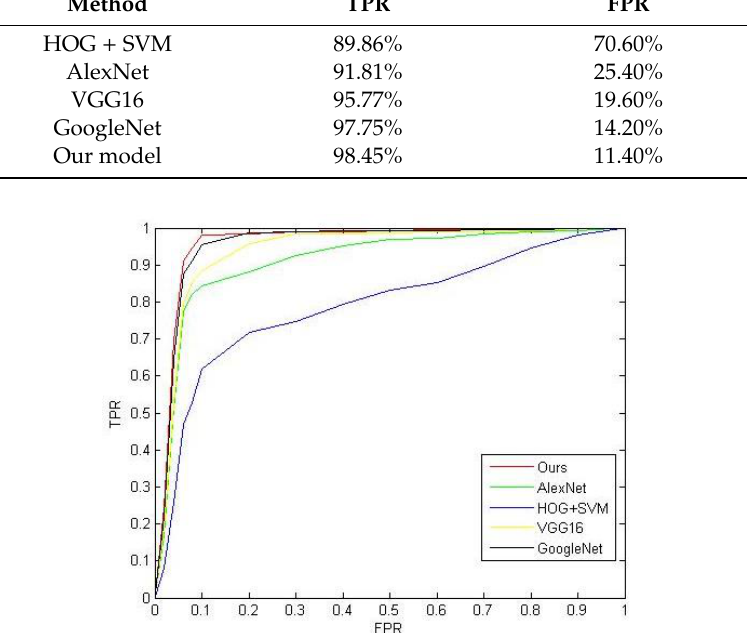
Figure 8. ROC curve.